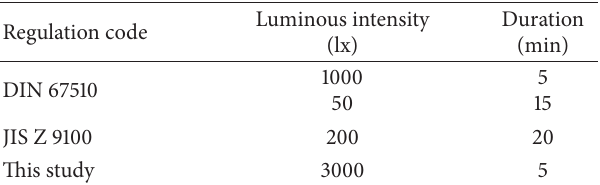
Table 1: The luminous intensity and exposure duration used in this